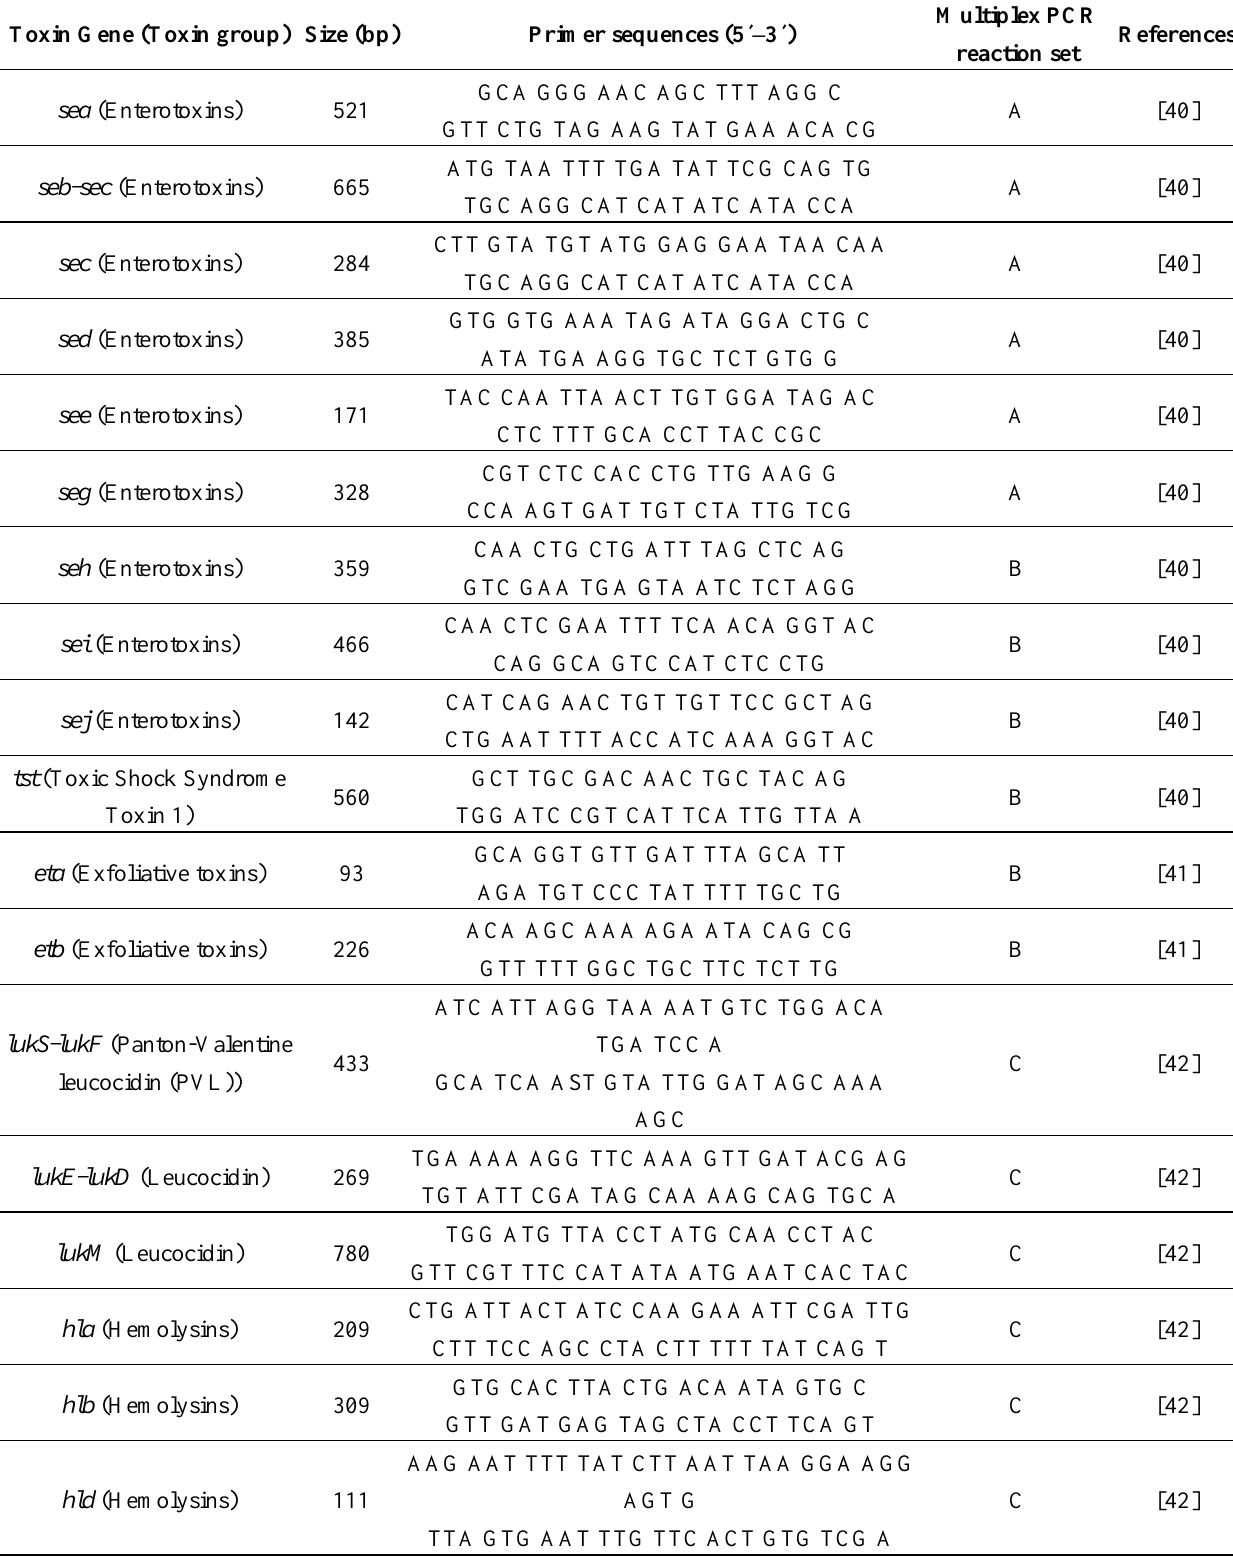
Table 3. Multiplex PCR primers, reaction sets, references, and toxin groups for the screened toxin